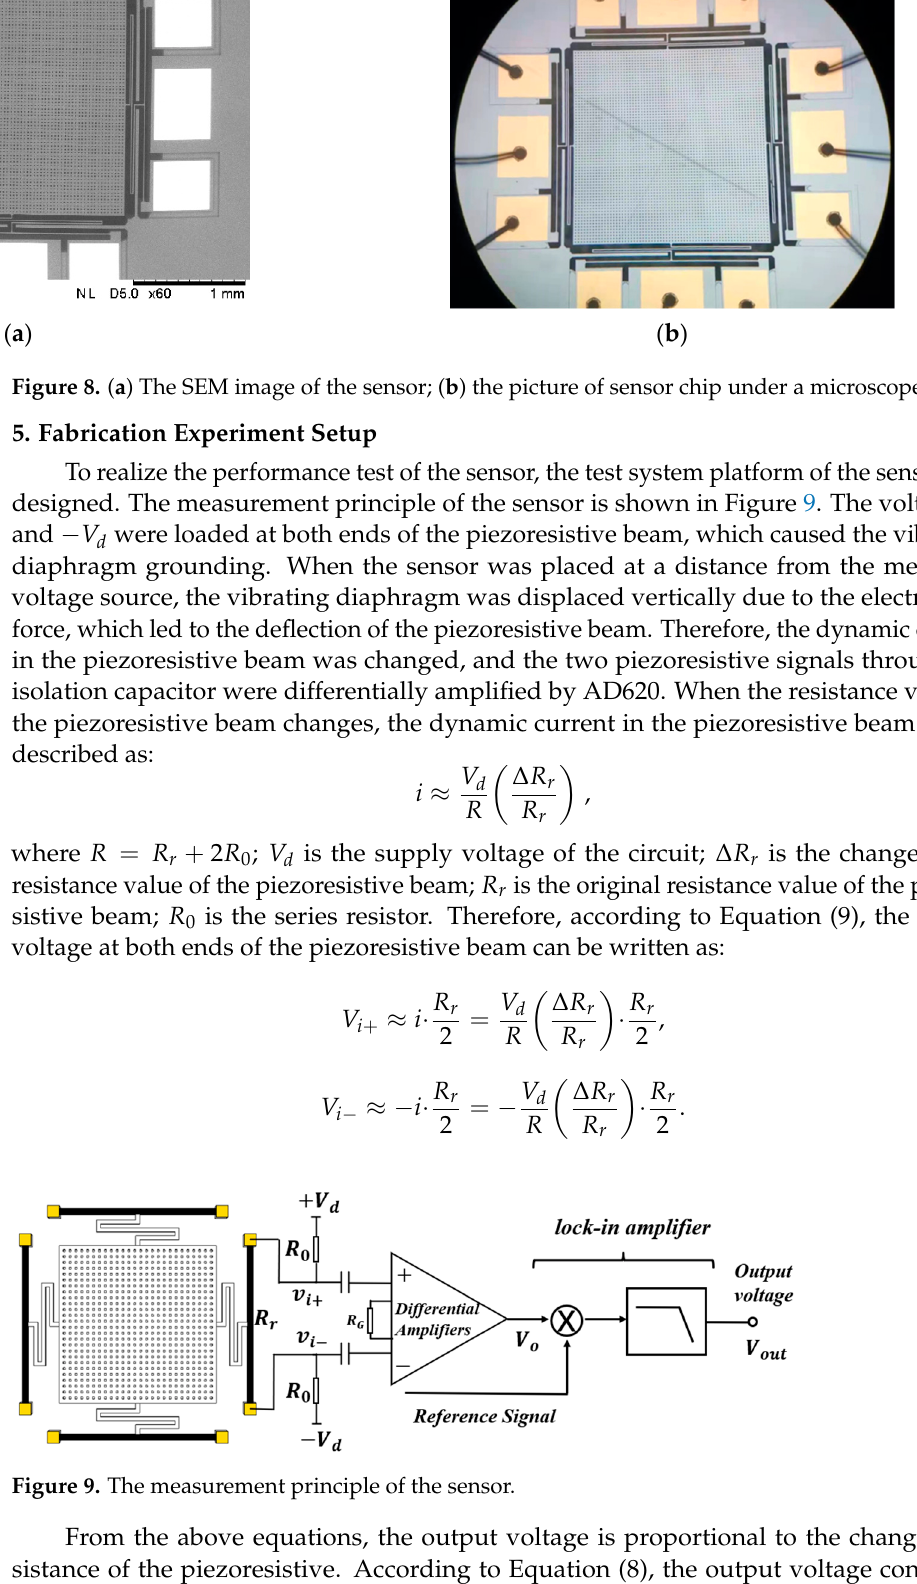
high-precision-power YOKOGAWA 2558A was used as the measured voltage power to provide AC voltages in the voltage range of 0–1200 V at the frequency range of 40–1000 Hz. Therefore, the measured voltage caused the deflection of the piezoresistive beam because of the electrostatic force between the vibrating diaphragm and the measured voltage. An HF2LI lock-in amplifier was used to measure the second-harmonic compo- nent of the output signals.